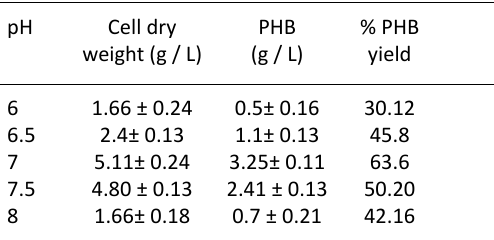
Table 7. Effect of pH values on PHB production by Bacillus